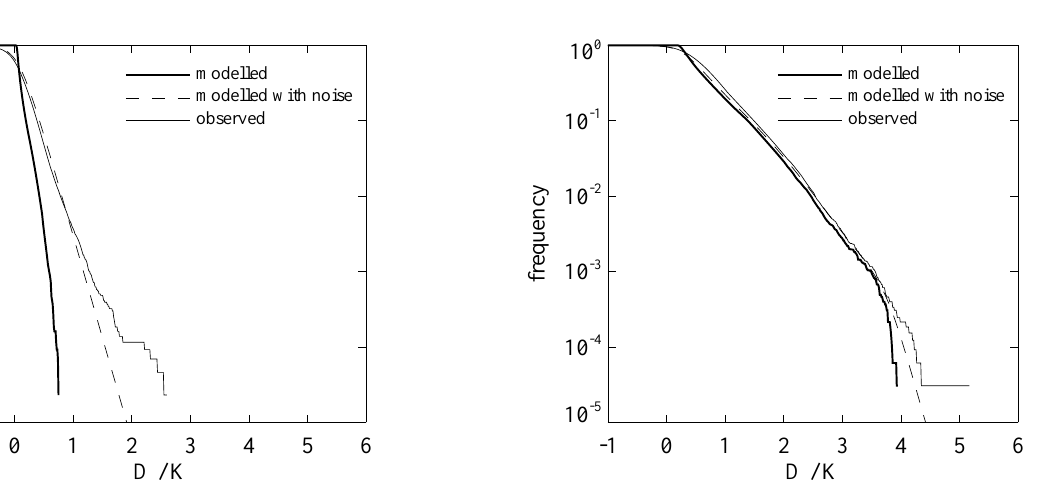
Fig. 4. Fit between the probability distributions of modelled warm- ing > D and observed warming > D at 18:00LT for small inte- grated heat flux (4.3MJm − 2 ) . The modelled warming ranges from zero to 0.8K. When the background noise is added, the modelled distribution matches the observed distribution. The fit is poor at the very largest values of warming but does include non-zero probabil- ity of negative warming.